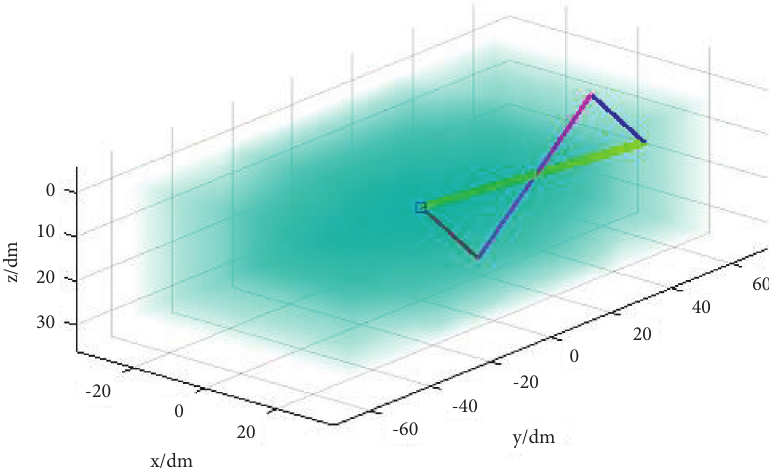
Figure 3: Any two-point channel propagation path.